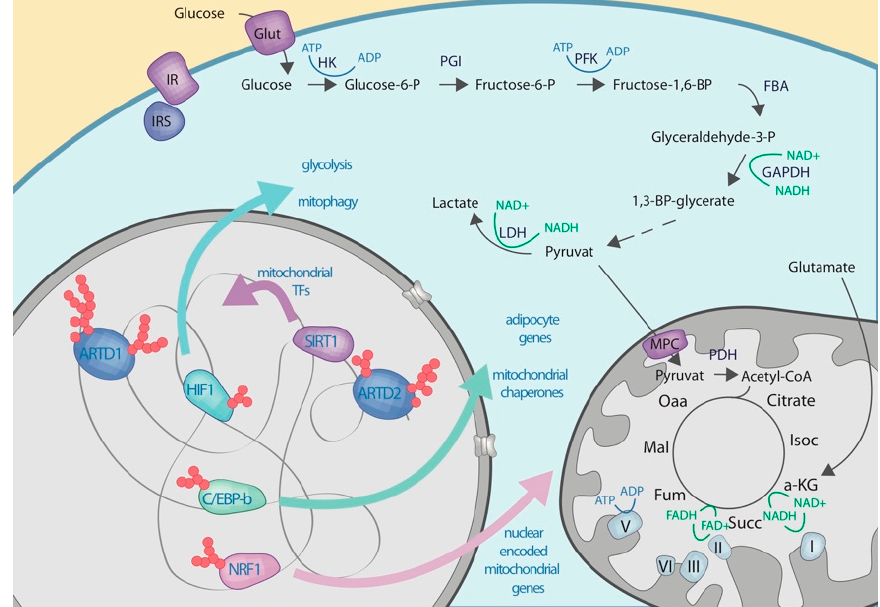
Figure 4. Schematic overview on the functional contribution of nuclear ARTs to carbohydrate metabolism. Metabolic pathways are shown as in Figure 1.